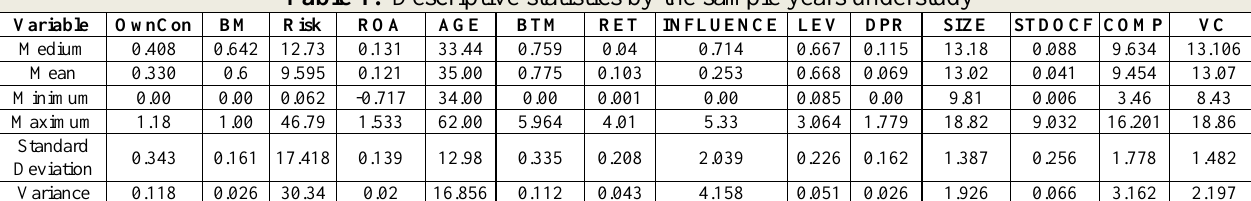
Table 1. Descriptive statistics by the sample years